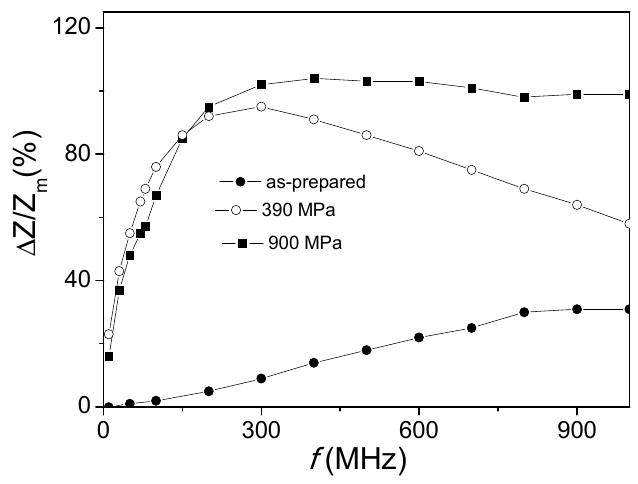
Figure 5. Δ Z/Z m (f) dependencies of Fe 75 B 9 Si 12 C 4 as-prepared and stress-annealed microwires.